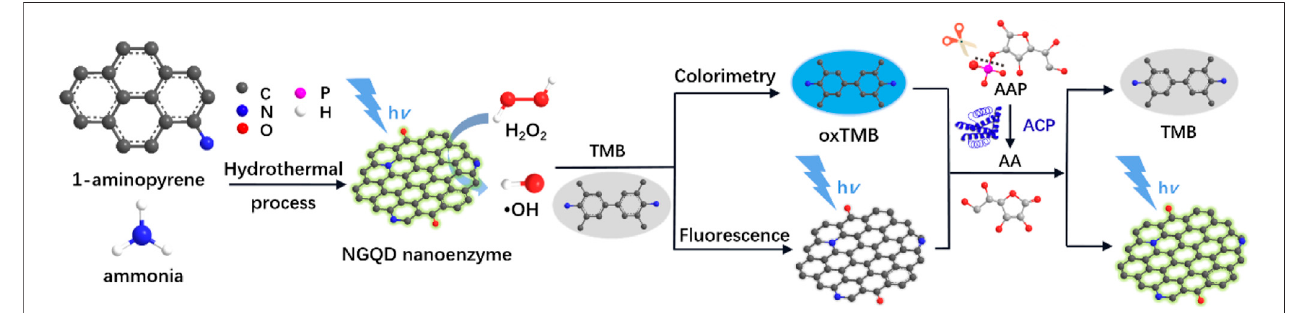
FIGURE1| Schematicillustrationfortheone-steppreparationofNGQDnanozymesandthecolorimetric/ fl uorescentdual-modalitysensingofH 2 O 2 ,AA,andACP.